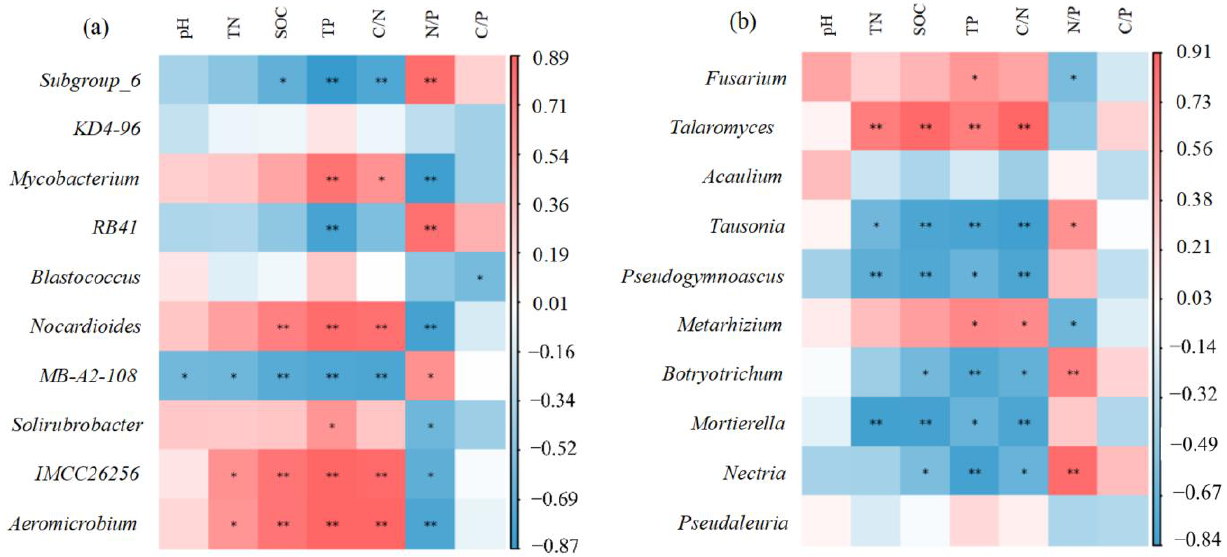
Figure 2. Pearson correlation analysis between soil physicochemical properties and the top ten phyla of soil bacterial and fungal communities. Colors indicate relevance. The color corresponds to the ruler value on the right side of the image. Red means positive correlation, and blue means negative correlation. ** and * significant at 1% and 5% probability, respectively. ( a ) Correlation between bacterial phyla and soil properties. ( b ) Correlation between phylum fungi and soil properties.